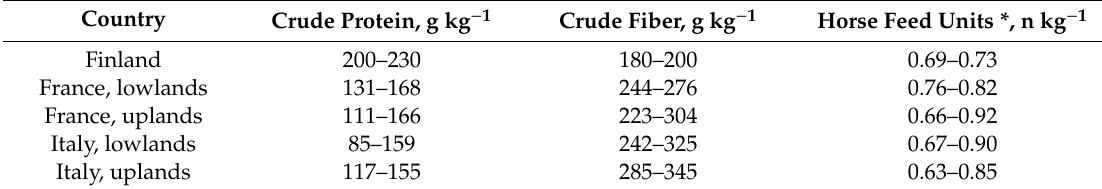
Table 5. Chemical components and estimated energy content of pasture in European areas. Values expressed on a dry matter basis [5,111].